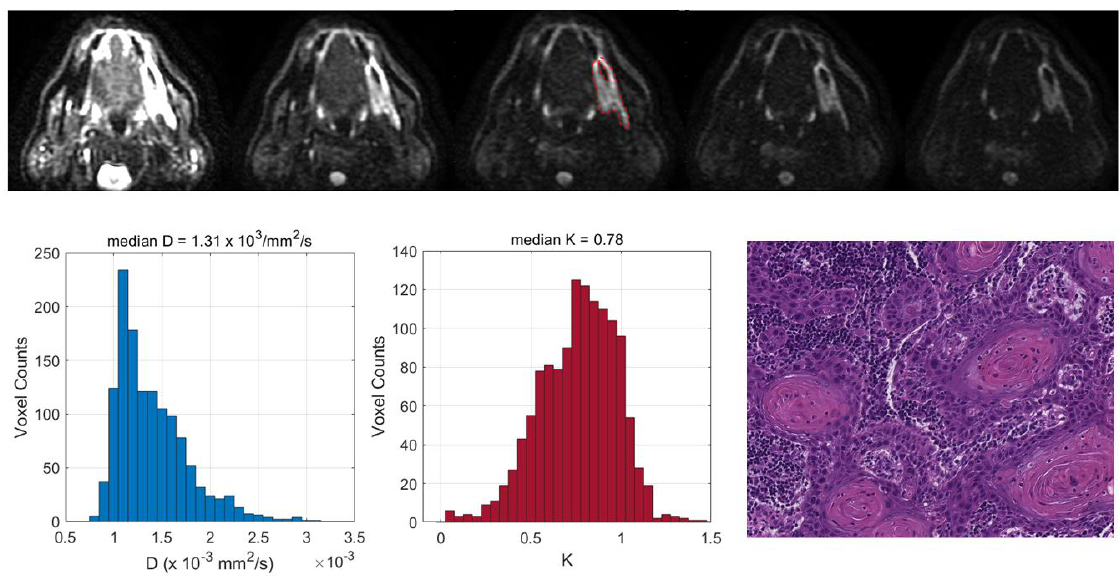
Figure 3. Top (from left to right): central section of a retromolar trigone tumor in a 62-year-old woman on diffusion-weighted images obtained with increasing values: b = 0, 500, 1000, 1500 and 2000 mm 2 /s; user-defined lesion contour is in red. Bottom (from left to right): histograms of D and K values derived from the entire tumor volume, indicating both a restriction in the water molecule diffusivity and increased kurtosis as well as the presence of high levels of tumor-infiltrating lymphocytes (TILs) (hematoxylin – eosin; original magnification: 20×).